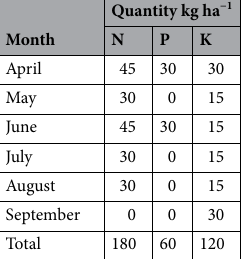
Table 3. Schedule of mineral fertilizer